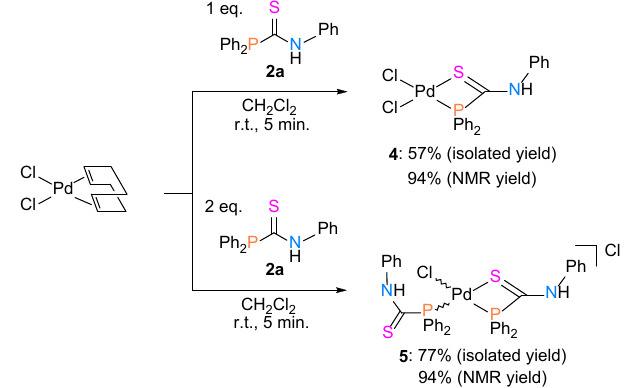
Scheme 7. Reactions of Pd(COD)Cl 2 with Ph 2 PC(S)NHPh 2a .